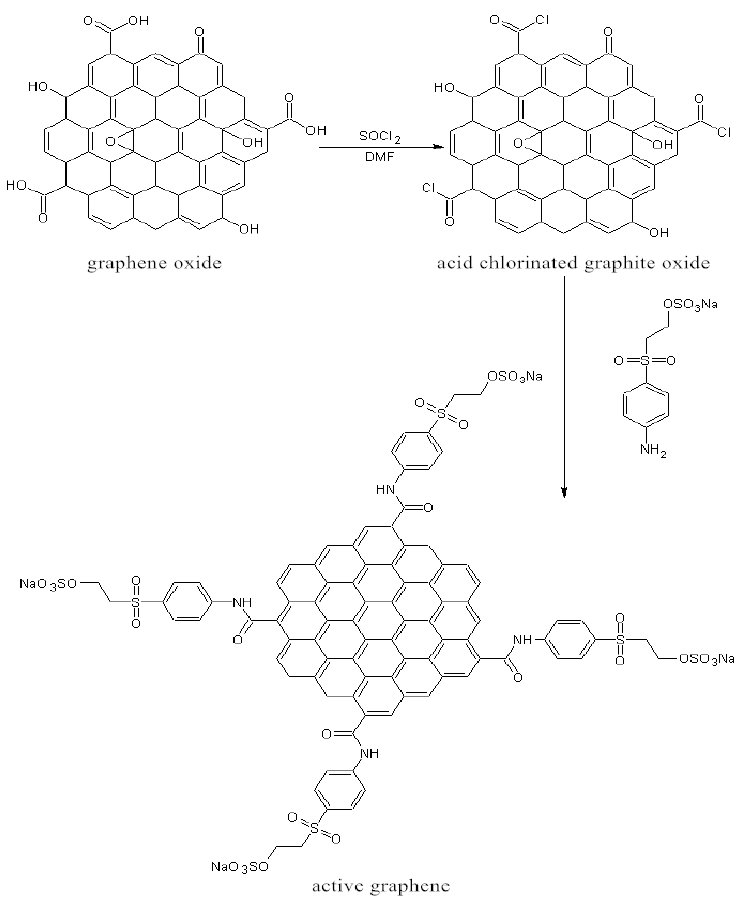
Figure 2. Reaction mechanism for synthesis of active graphene.